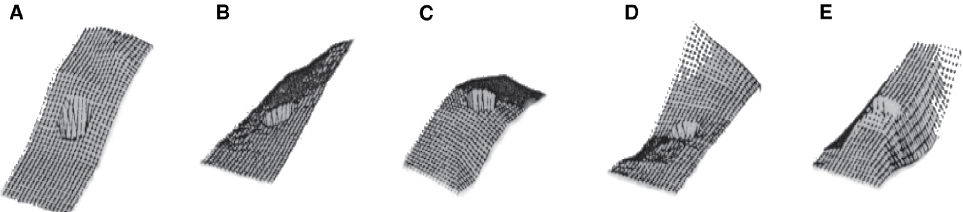
Figure 6: Different resonance modes by modal analysis (holed specimen). (A) First mode (B) second mode (C) third mode (D) fourth mode (E) fifth mode.